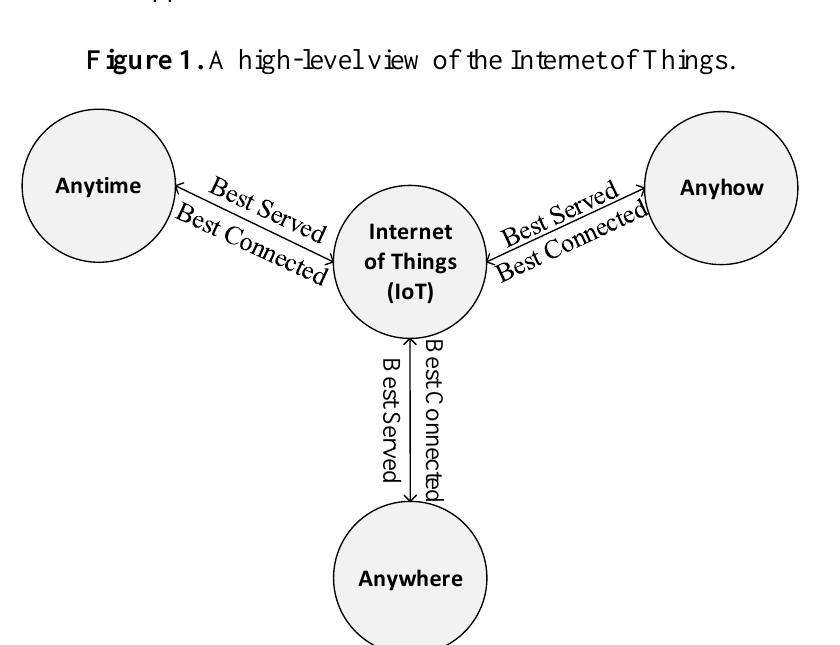
Figure 1. A high-level view of the Internet of Things.